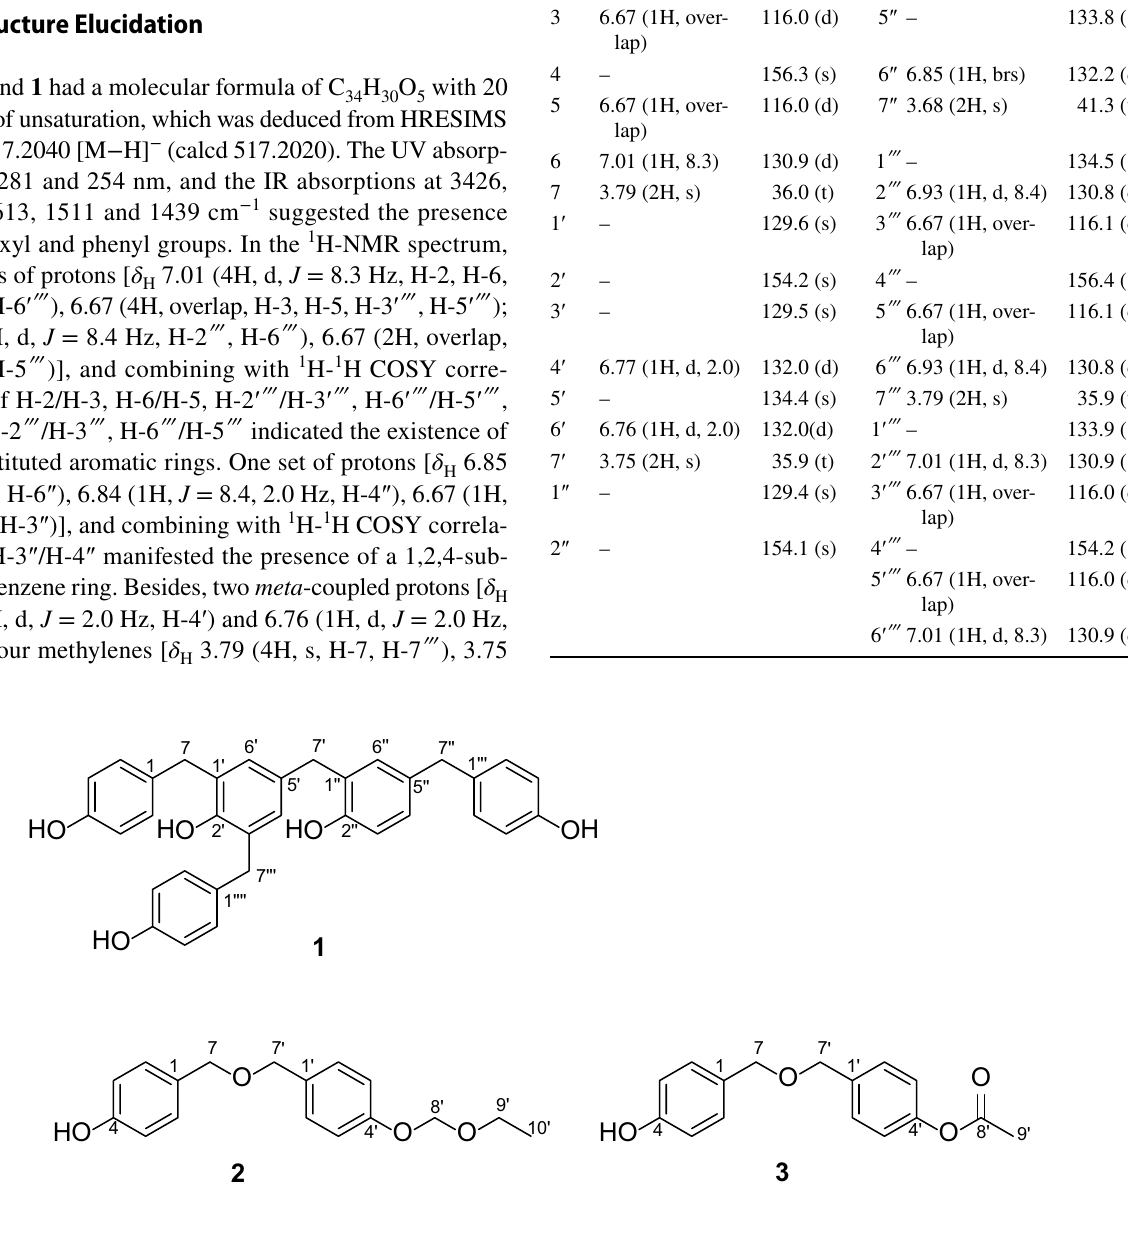
Fig. 1 Structures of compounds 1 – 3